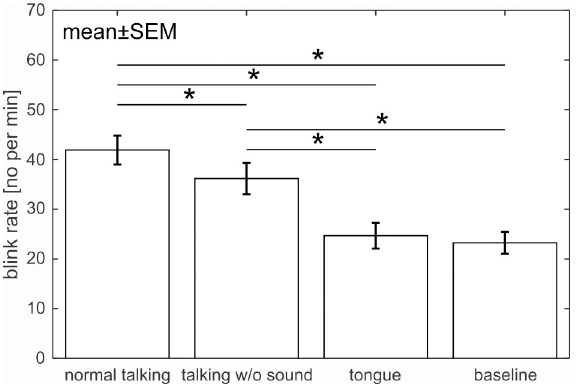
Fig 8. Influence of motor activity varying in complexity on the blink rate. All pair-wise post-hoc tests revealed a significant difference in blink rate except for the tasks “tongue” and “baseline”. EMG analysis showed that participants fulfilled task